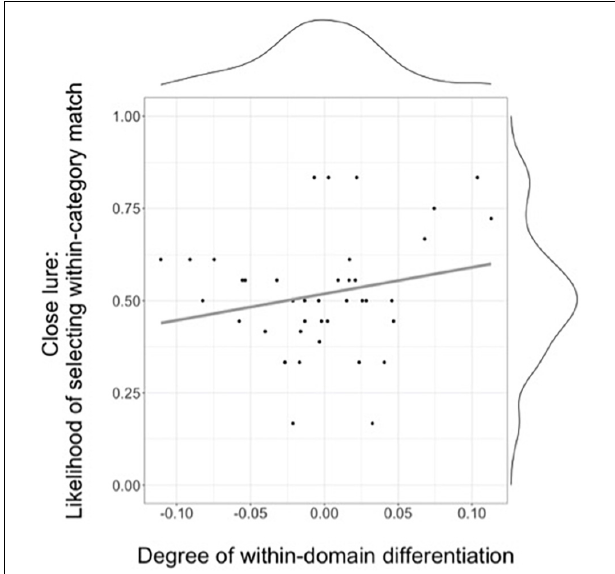
FIGURE 4 | Relation between the degree of within-domain differentiation (with higher scores representing a larger distance between in-category and out-of-category pairs in the Spatial arrangement task) and the likelihood of selecting the within-category match in the close lure condition of the Inference